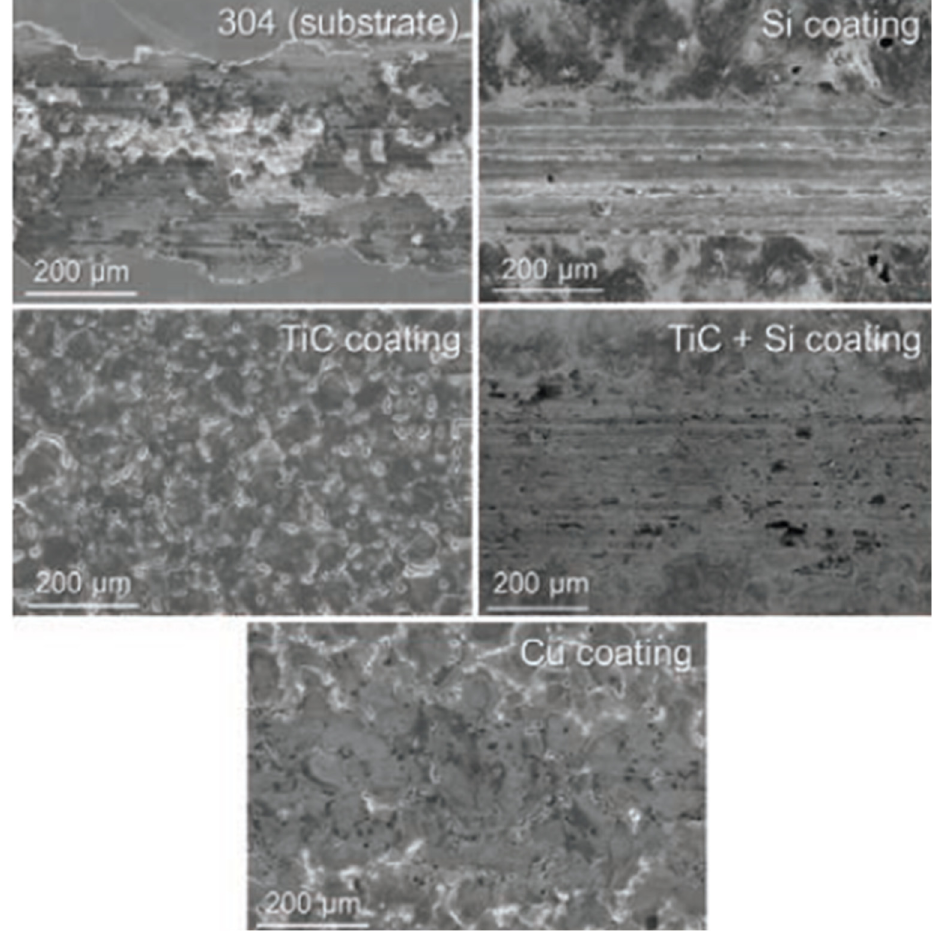
Figure 24. SEM images showing the wear tracks of 304 stainless steel coated by Si, TiC, TiC + Si, and Cu [132]. (With kind permission from Elsevier).